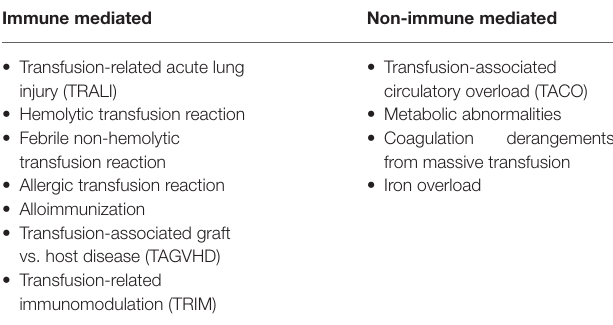
TABLE 2 | Non-infectious complications of transfusion. Immune